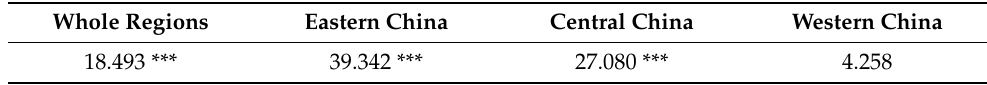
Table 8. Sargan–Hansen test results.